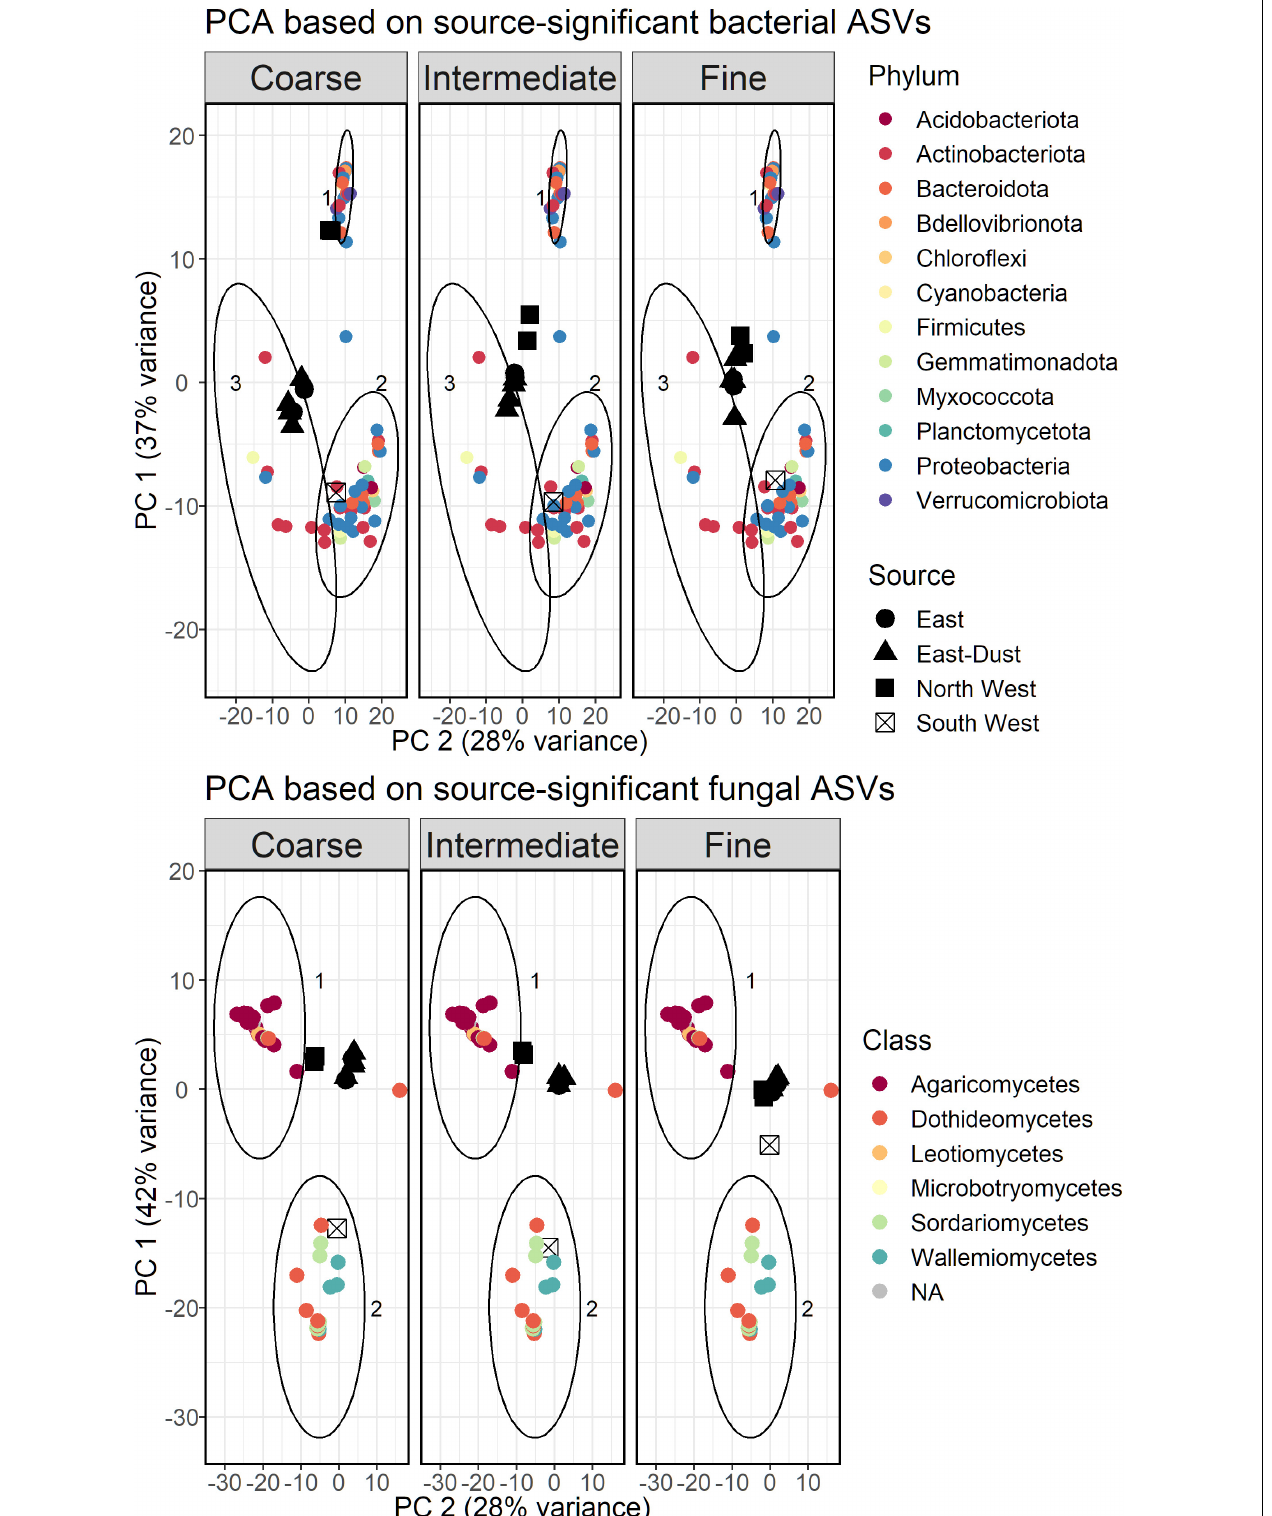
FIGURE 5 | PCA bi-plot based on a subset of bacterial (Top) and fungal (Bottom) ASVs found to be linked to the source of the air-masses. Clusters were constructed using k-means; clusters 1 and 2 in bacteria and fungi alike represent ASVs that correlated with North West and South West air-masses, respectively; cluster 3 was unique to bacteria and represents ASVs that correlated with East and East-Dust air-masses.